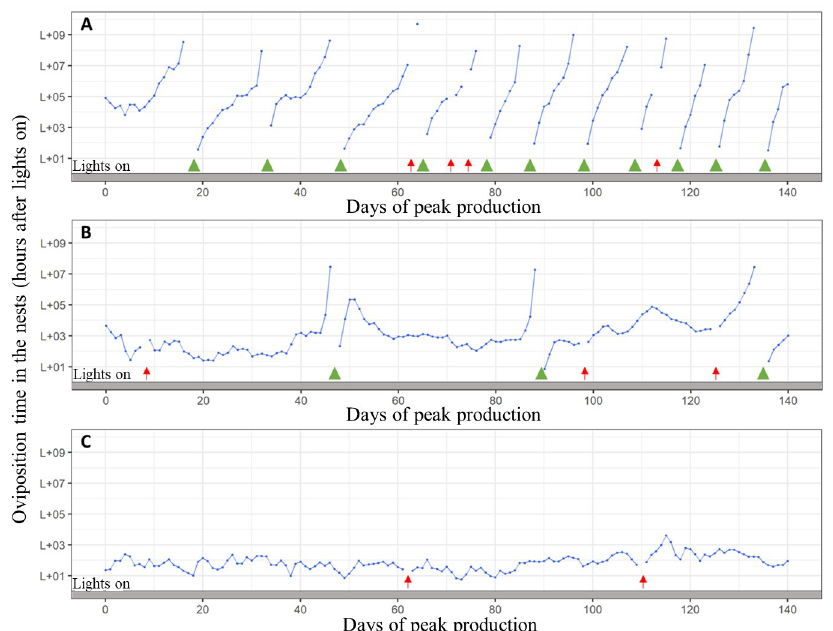
Fig 1. Laying patterns in the nests of three hens (A: short clutches, B: long clutches, and C: one long clutch without pause days) recorded with individual electronic nests for the 140 days of peak production (24–43 weeks of age). Blue points represent eggs laid, and blue lines connect eggs when there is no day without data that separate the eggs (i.e. a pause day (green triangles) or an egg laid off-nest (red arrows)). https://doi.org/10.1371/journal.pone.0251037.g001 LRN and CN or oviposition traits were stronger in the middle than at the peak of production, except for LVOI in WL. NAL was weakly to moderately correlated with LRN, CN, and oviposi- tion traits (-0.41 to +0.44). Phenotypic correlations were lower but consistent with genetic cor- relations. Phenotypic correlations for NAL with LRN and CN could not be estimated because all hens that were kept for analysis of LRN and CN performances had a value of 1 for NAL.